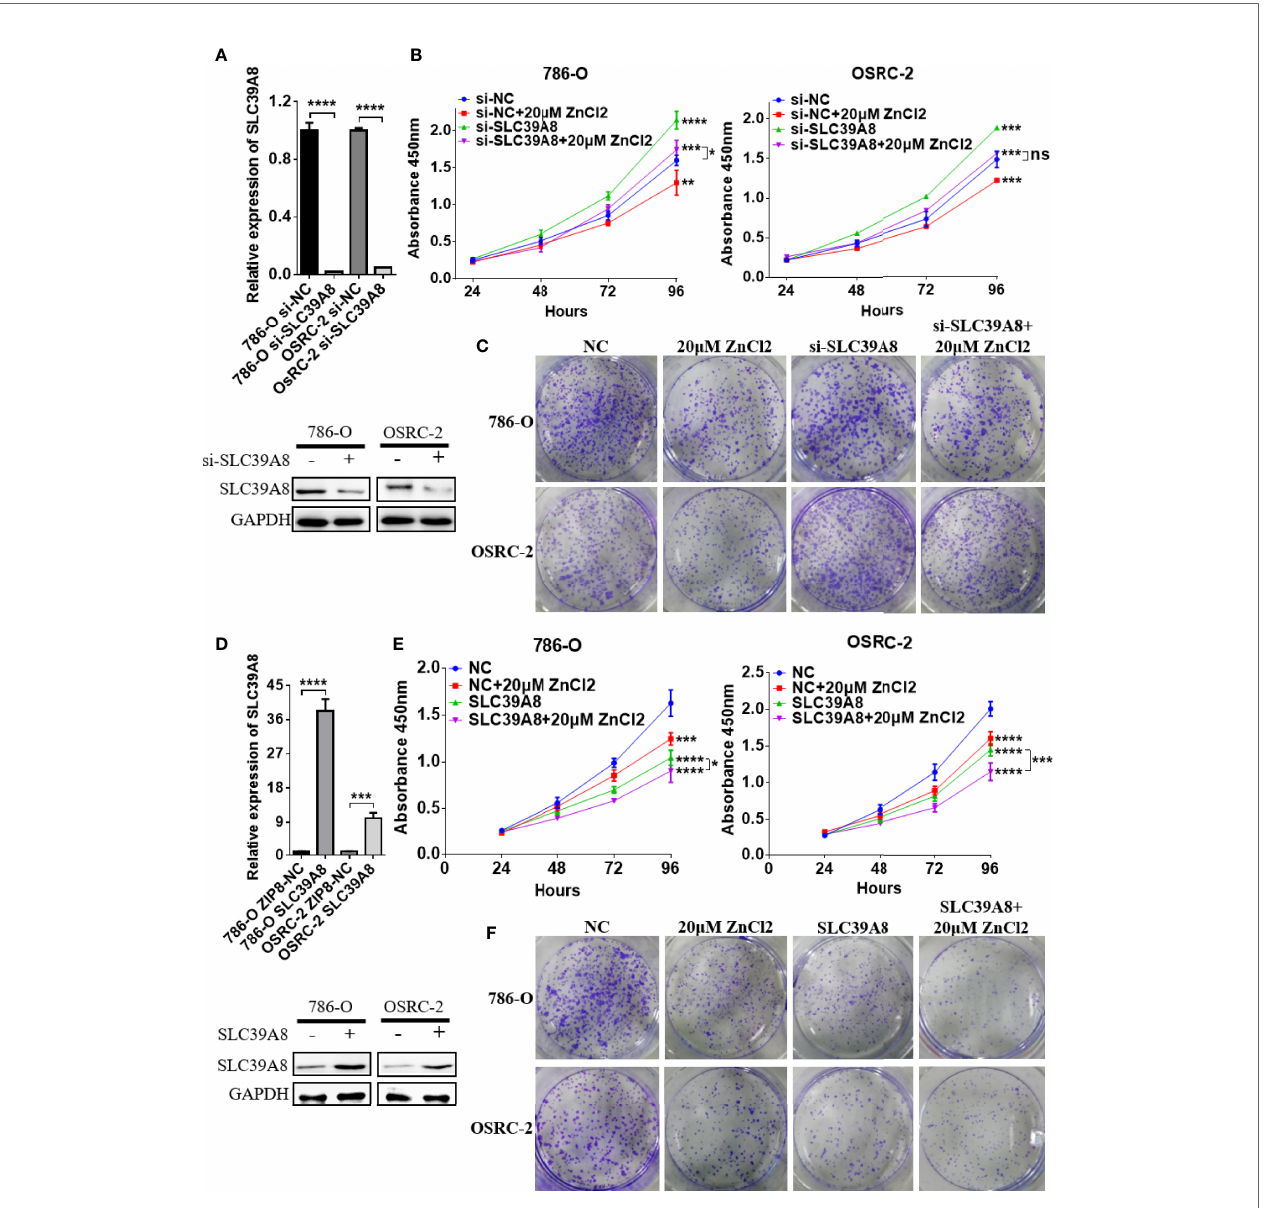
FIGURE 5 | SLC39A8/zinc inhibits the proliferation of ccRCC cells in vitro . (A) Quantitative real-time PCR and western blotting experiments of SLC39A8 knockdown in 786-O and OSRC-2 cells. (B, C) Cell proliferation assay and colony formation assay detected the effects of SLC39A8 knockdown with or without zinc supplementation on the proliferation of 786-O and OSRC-2 cells. (D) Quantitative real-time PCR and western blotting experiments of SLC39A8 overexpression in 786-O and OSRC-2 cells. (E, F) Cell proliferation assay and colony formation assay detected the effects of SLC39A8 overexpression with or without zinc supplementation on the proliferation of 786-O and OSRC-2 cells. The values of each group were presented as the mean ± standard deviation. *P < 0.05, **P < 0.01, ***P < 0.001, ****P <